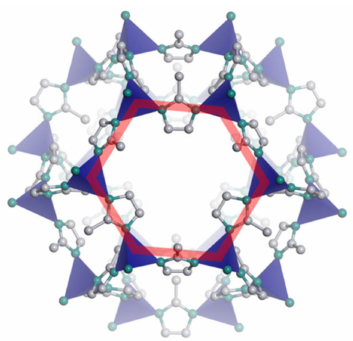
Figure 1. Structure of the Zeolitic Imidazolate Framework 8 (ZIF-8) framework.